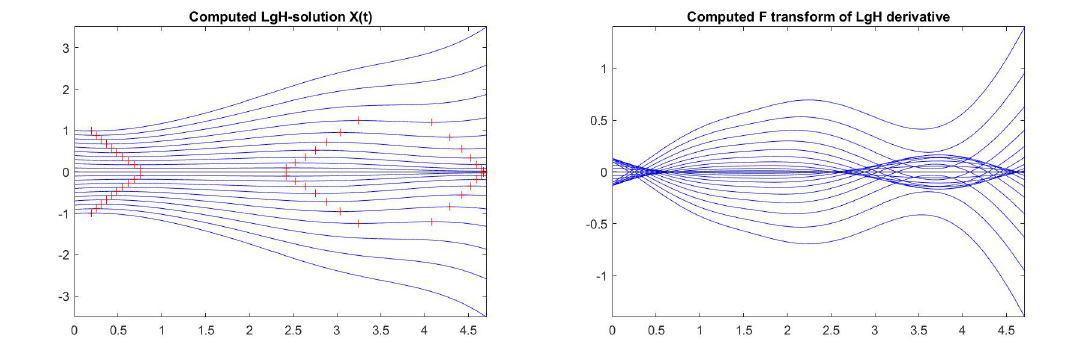
Figure 12. Problem IDE2, Meth = 2: Level-wise LgH-differentiable solution ( left ) and its LgH- derivative ( right ). For all α -cuts, there are one or three switching points which are not in the same position for the levels α ( left ); the LgH-derivative is represented on the right